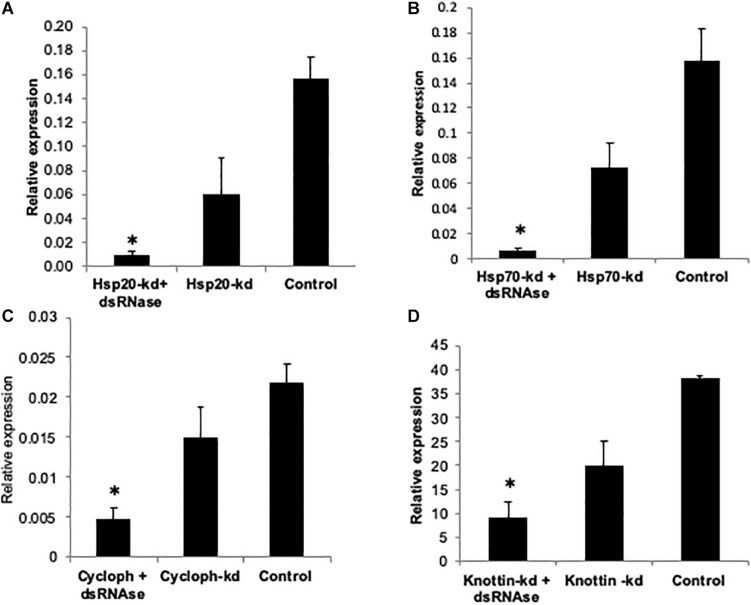
Relative expression of (A)
Hsp20
(B)
Hsp70
(C)
Cyclophitin
(D)
Knottin-1, compared to GFP control when normalized with tubulin. The error bar represent the standard deviation (n = 3) and ∗represents significant differences in mRNA transcripts compared to the control (P ≤ 0.05, Student’s t-test).